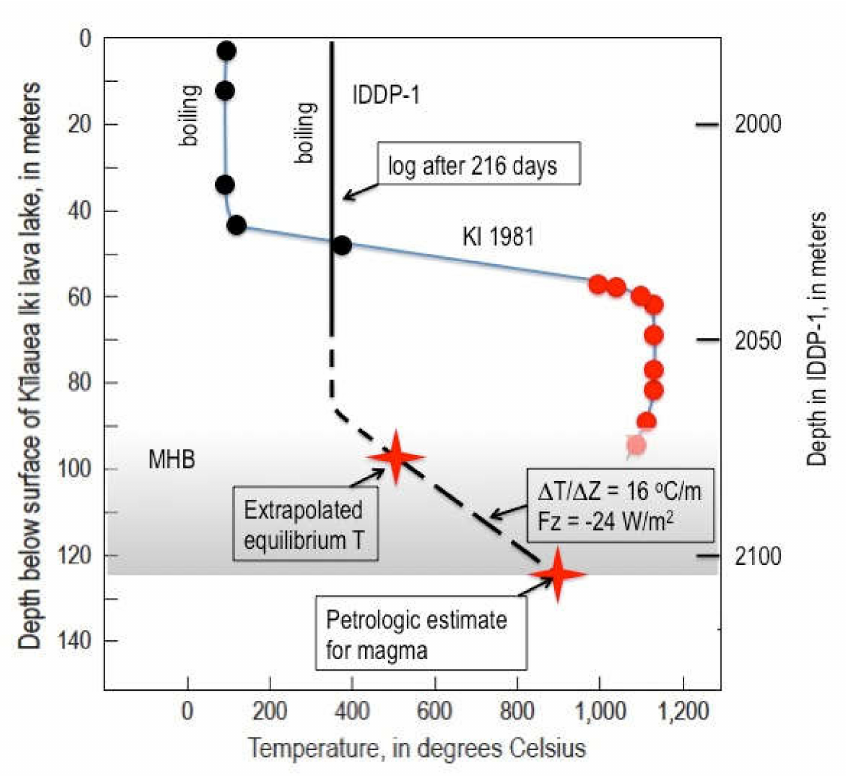
Figure 6. Temperature profile for IDDP-1 [26] compared with Kilauea Iki 1981 [16]. The depth and temperature scales are the same except that a much deeper interval is shown for IDDP-1; hence, the boiling-controlled portion of the profile is hotter. The molten portion in IDDP-1 is rhyolite rather than basalt, so that temperature is